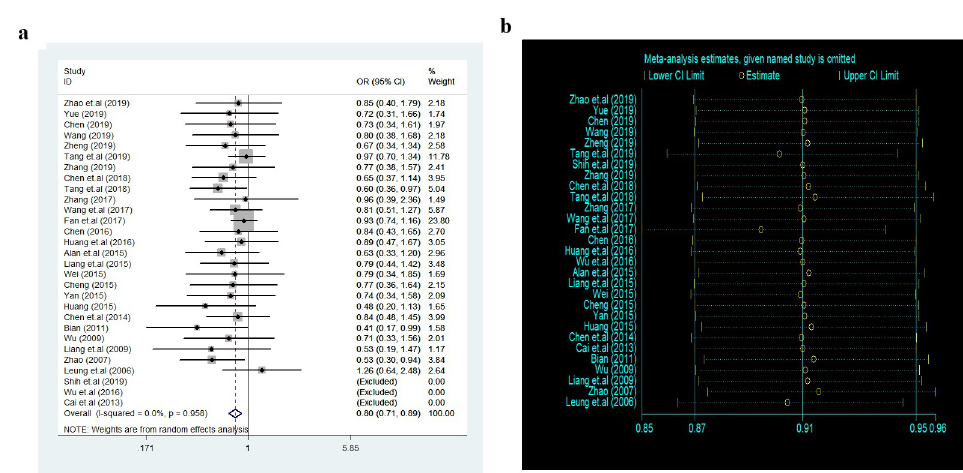
Fig 5. Heterogeneity analysis and sensitivity analysis: (a) Heterogeneity analysis; (b) Sensitivity analysis.